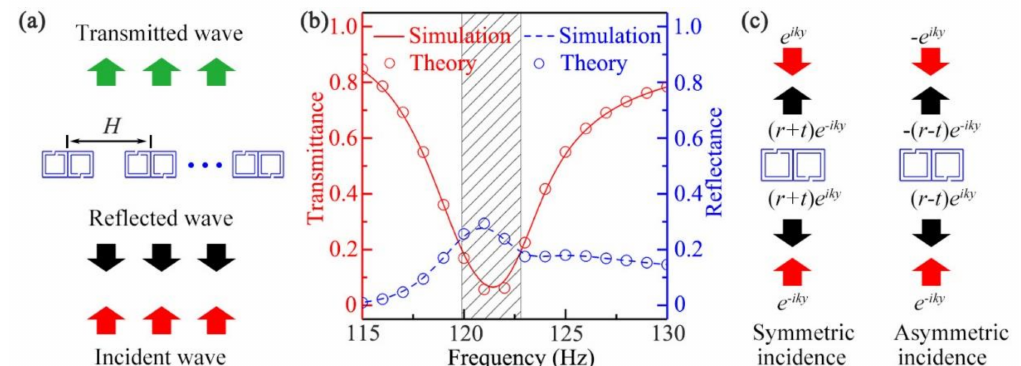
Figure 2. ( a ) Schematic of the performance simulation of the designed open, sound-insulation barrier; ( b ) the transmittance (red solid line for simulation and red open circle for theory) and reflectance spectra (blue dashed line for simulation and blue open circle for theory) of the open, sound-insulation barrier created by a normal incidence of sound; ( c ) schematic of symmetric and asymmetric